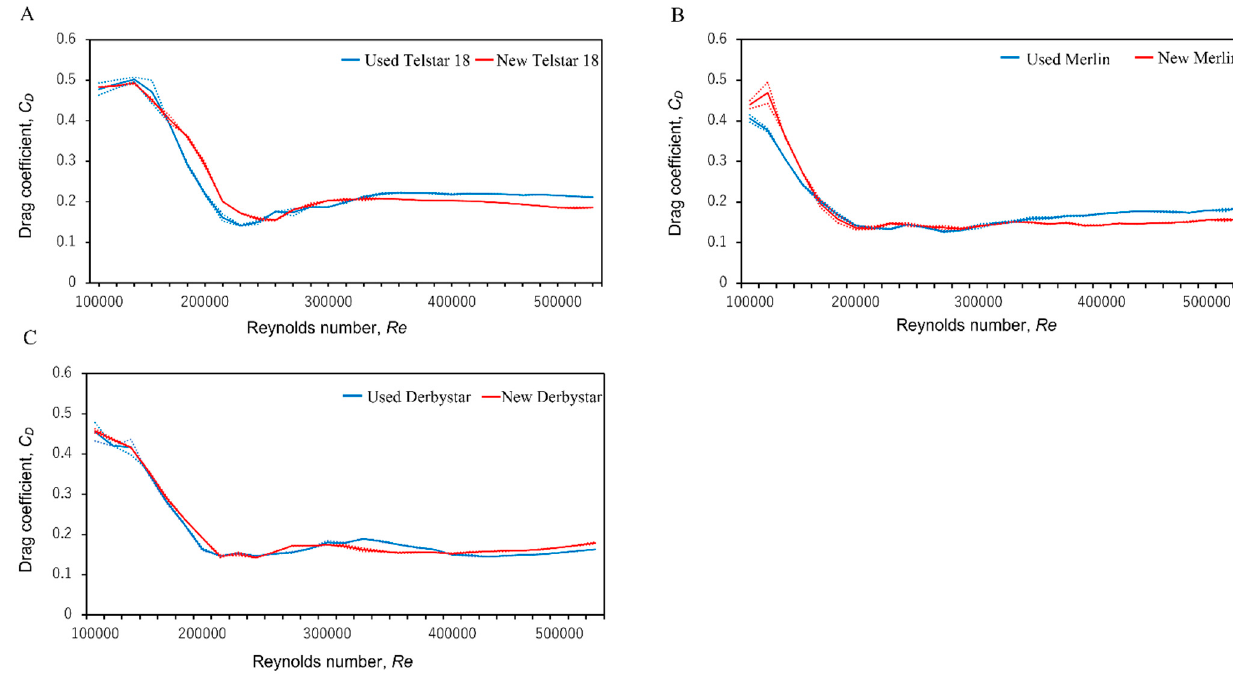
Figure 4. ( A – C ) show the drag coefficients obtained for the Telstar18, Merlin, and Derbystar soccer balls, respectively.